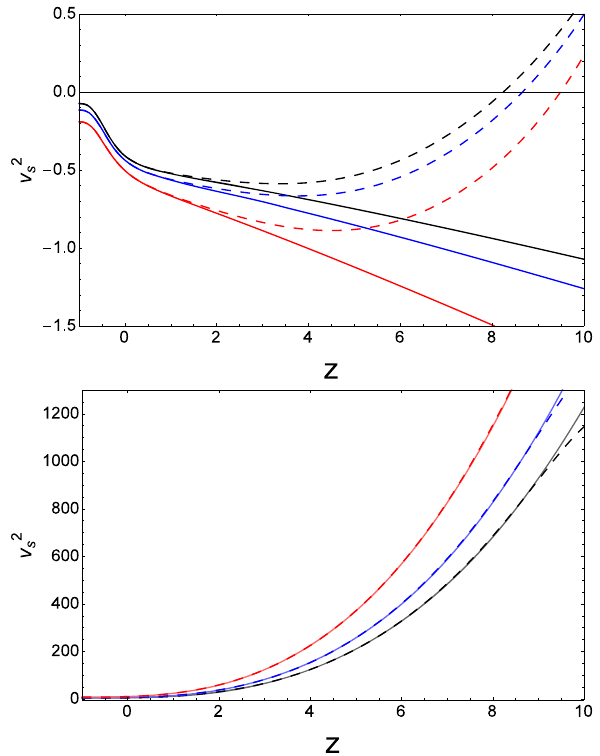
= 0 . 73, D and b 2 as given in Fig. 6. 1 2